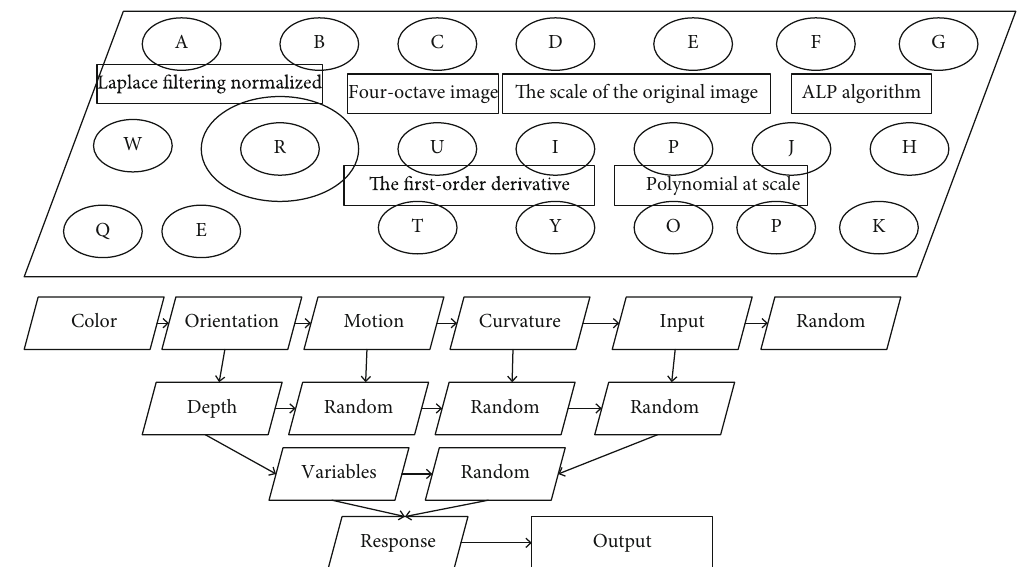
Figure 1: Algorithmic framework of multiple linear regression